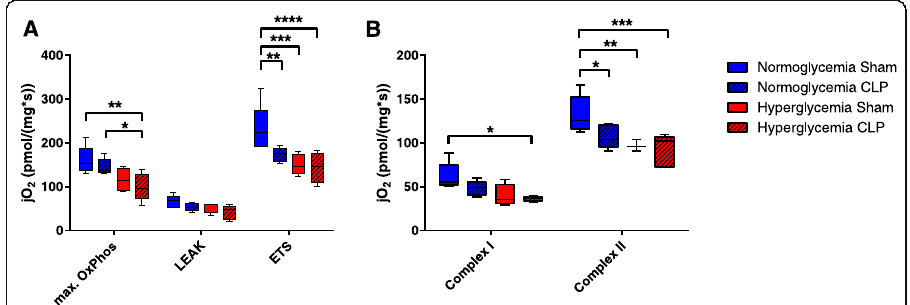
Fig. 2 Mitochondrial respiratory activity. jO 2 oxygen flux. a Maximum respiratory activity in the coupled (max OxPhos), leak (LEAK), and uncoupled state (ETS). * p ≤ 0.05, ** p ≤ 0.01, *** p ≤ 0.001, **** p = ≤ 0.0001. b Maximum respiratory activity in the coupled state depending on complex I activity ( Complex I ) and maximum respiratory activity in the uncoupled state with inhibition of complex I ( Complex II ). * p ≤ 0.05, ** p ≤ 0.01, *** p ≤ 0.001. All data is presented as median (interquartile range). Kruskal-Wallis analysis of variance on ranks with post hoc Dunn ’ s test